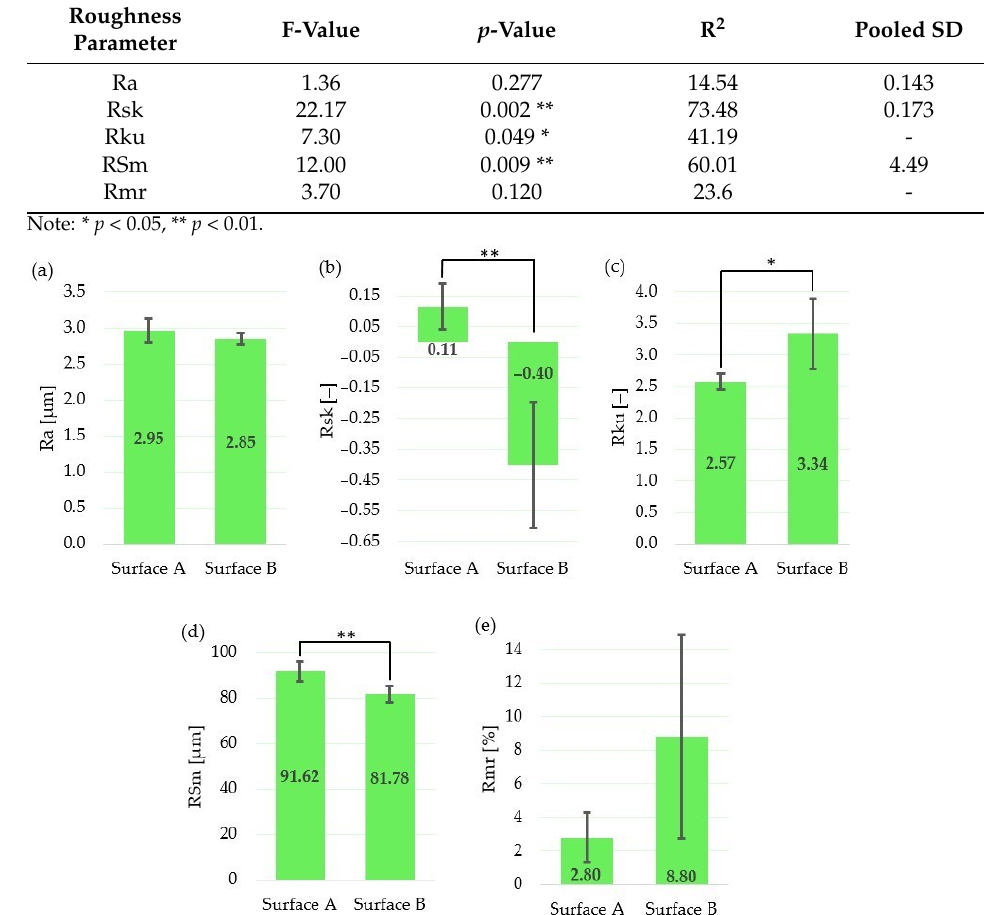
Figure 5. Evaluation of surface roughness parameters for Surface A and Surface B: ( a ) arithmetical mean height Ra; ( b ) mean width of the profile elements RSm; ( c ) relative load length ratio Rmr; ( d ) skewness Rsk; ( e ) kurtosis Rku; * statistically significant difference between means of roughness parameters at the significance level of 0.05; ** statistically significant difference between means of roughness parameters at the significance level of 0.01.